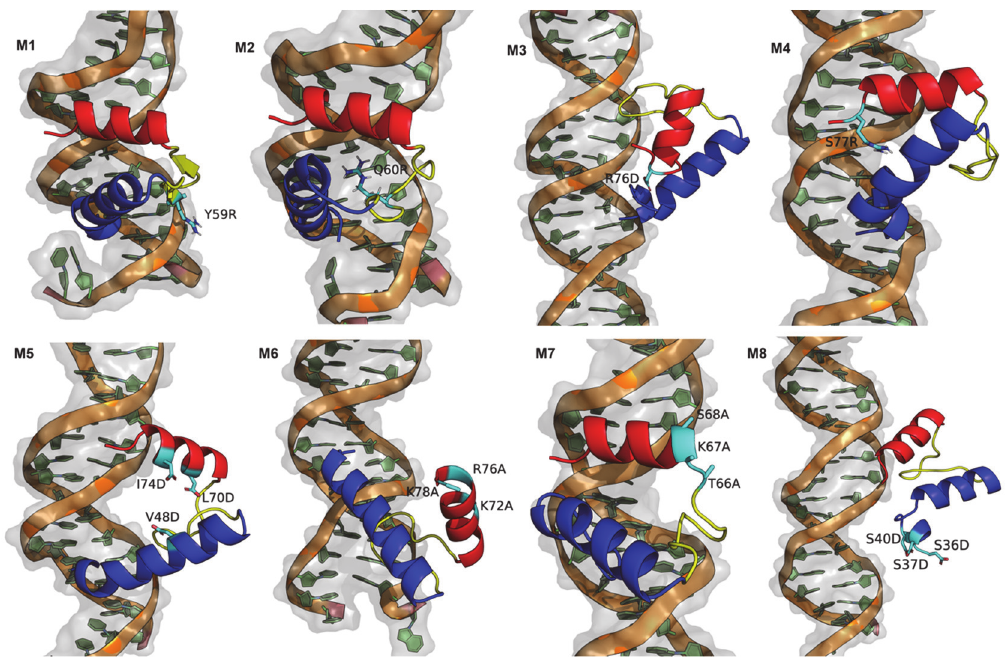
Figure 7. Representative structure from all evaluated mutation systems. p10 protein is colored according to the previously used color code: N-terminal helix in blue, the loop in yellow, and the C-terminal helix in red. The mutated labeled residues are identified as sticks, colored in cyan.